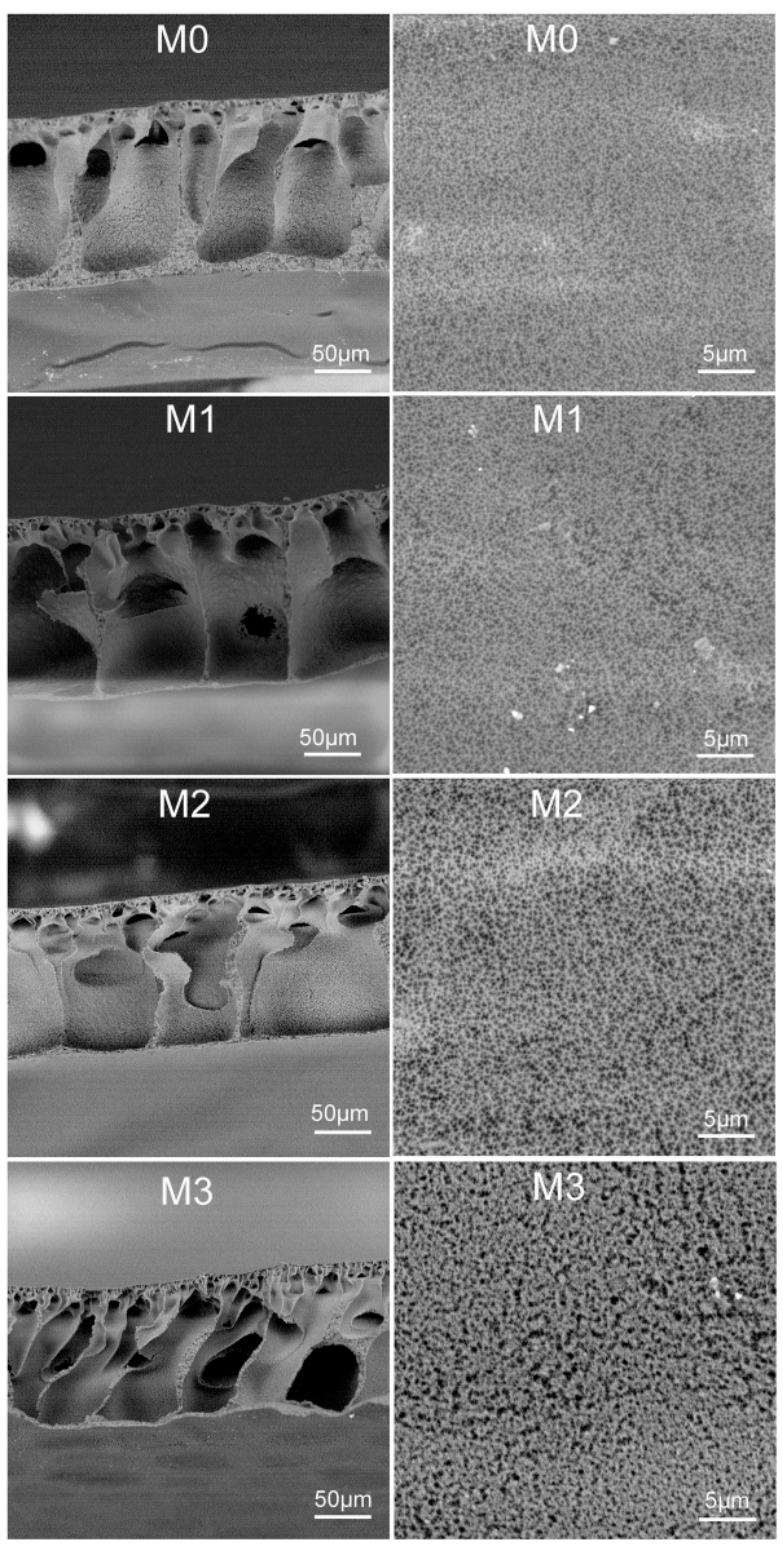
Figure 3. Cross-sectional and surface structures of membranes.